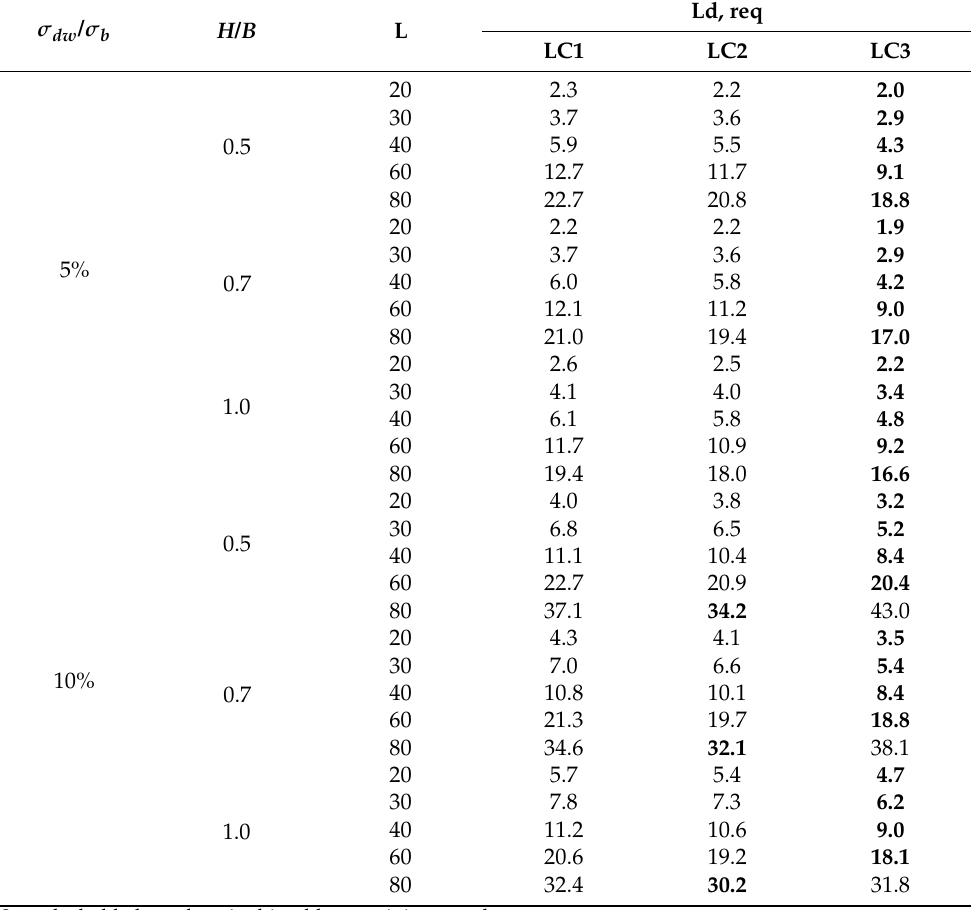
Figure 14. Comparisons between the design intermediate diaphragm spacing in the design codes and minimum required intermediate diaphragm spacing for different spans and load combinations at the 5% normal stress ratio. ( a ) 𝐻/𝐵 = 0.5 , ( b ) 𝐻/𝐵 = 0.7 , and ( c ) 𝐻/𝐵 = 1.0 .